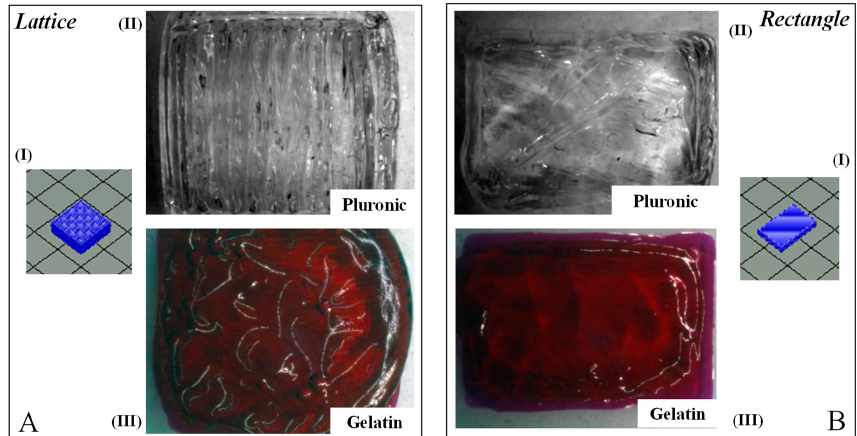
Figure 1. Gross Morphology of lattice and rectangular-sheet structures printed using pluronic and gelatin. ( AI , BI ) depict the stl. file image for the lattice and rectangular structures, respectively. ( AII , BII ) represent the en-face images for the same structures printed using Pluronic F-127. ( AIII , BIII ) are representations of the en-face images for lattice and rectangular patterns printed using the f-gelatin-based bioink, respectively.